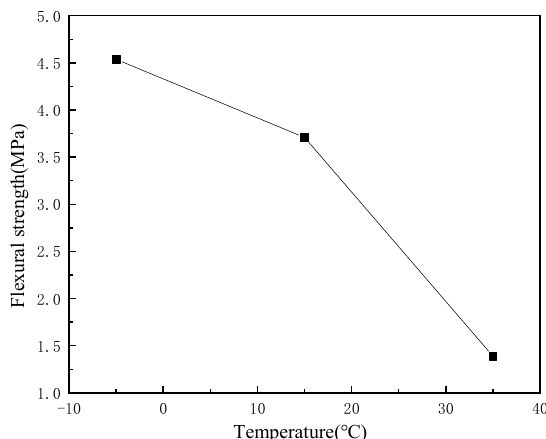
Figure 3. Flexural strength of the SFP.